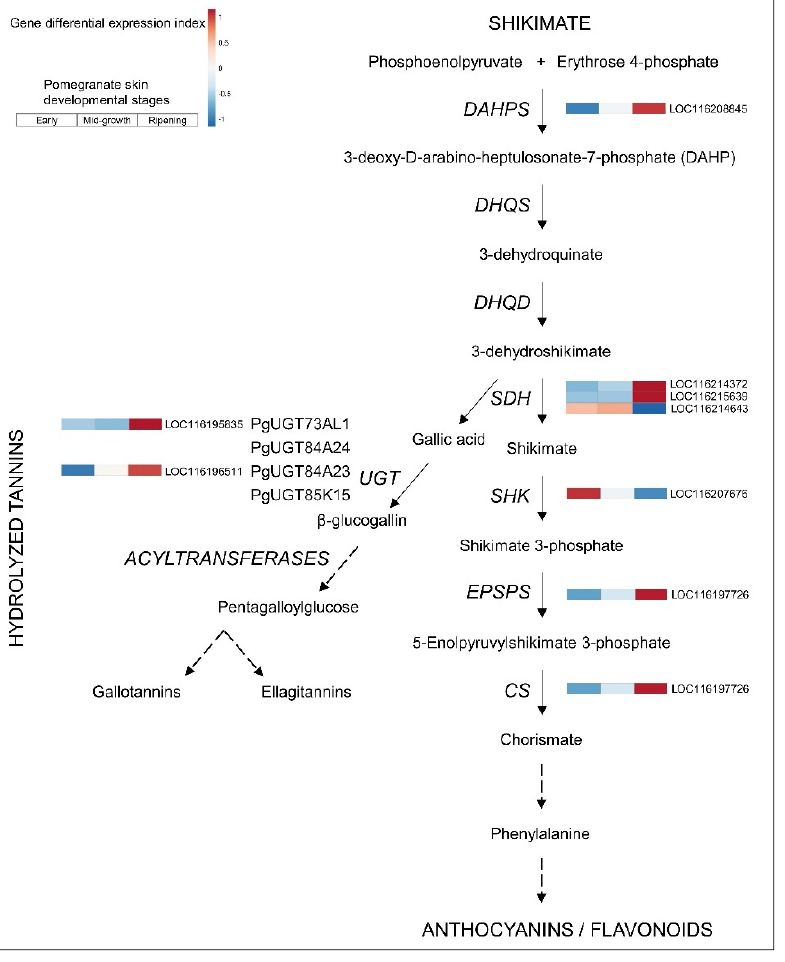
Figure 6. Shikimate and hydrolyzable tannin pathways in pomegranate skin. See Figure 3 legend for details. Expression level values and full gene names are given in Table S10.